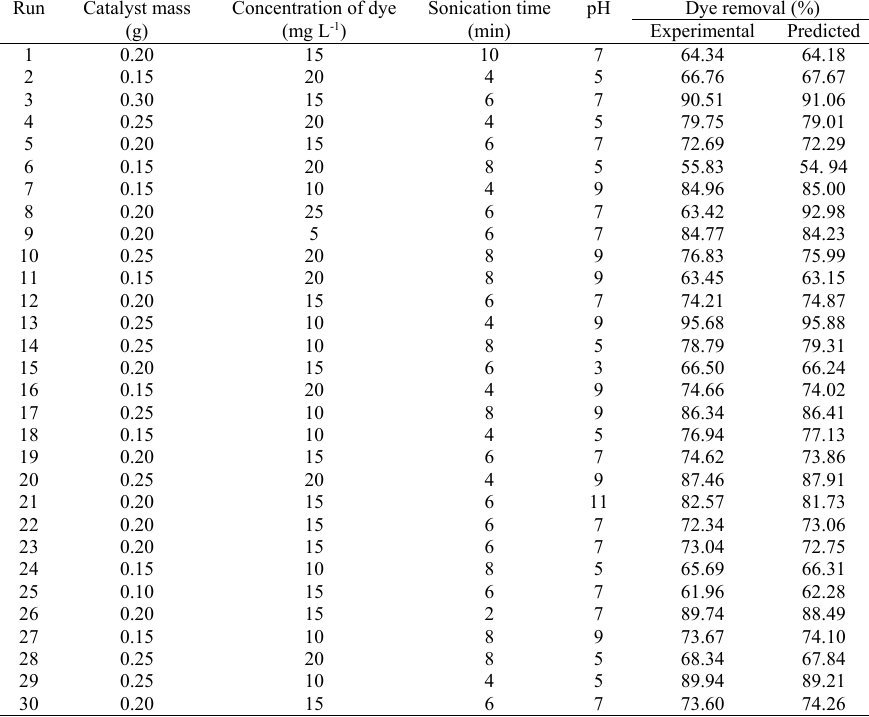
Table 3. Result of central composite design.